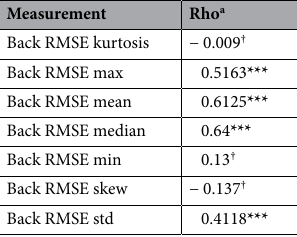
Table 1. Pearson’s correlation coefficients for the root mean squared error of the residuals for the back position against the cow’s lameness score 0–3. a The root mean squared errors were calculated from the residuals of key points on the back to the back regression line (outlined in “Back posture analysis”). The indicated probability thus: † P < 0 . 10 , * P < 0 . 05 , ** P < 0 . 01 , *** P < 0 . 001.